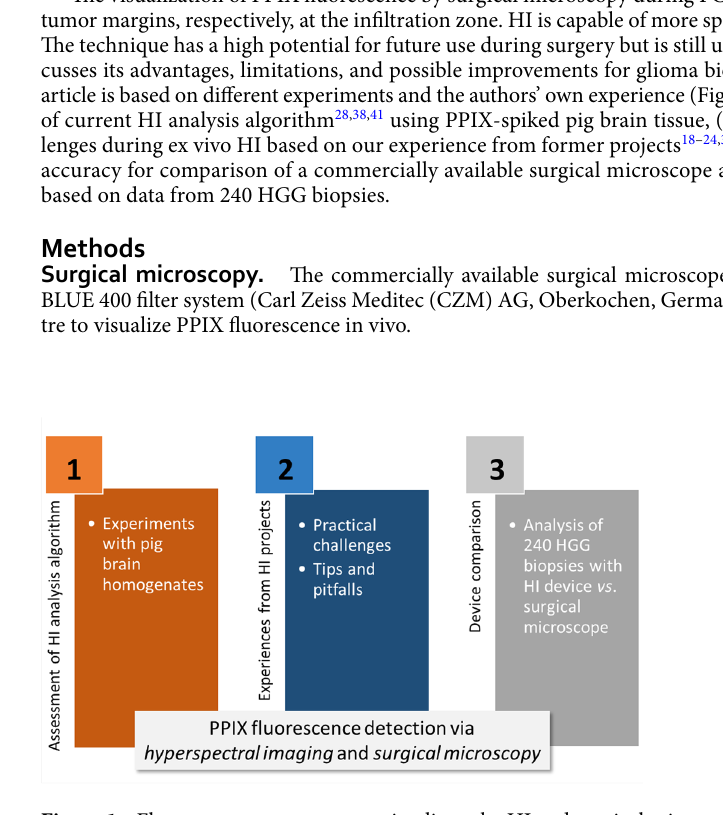
Figure 1. Fluorescence measurements in glioma by HI and surgical microscopy. Outline of this article, which evaluates the current status of both techniques, particularly of HI, the more sensitive of the